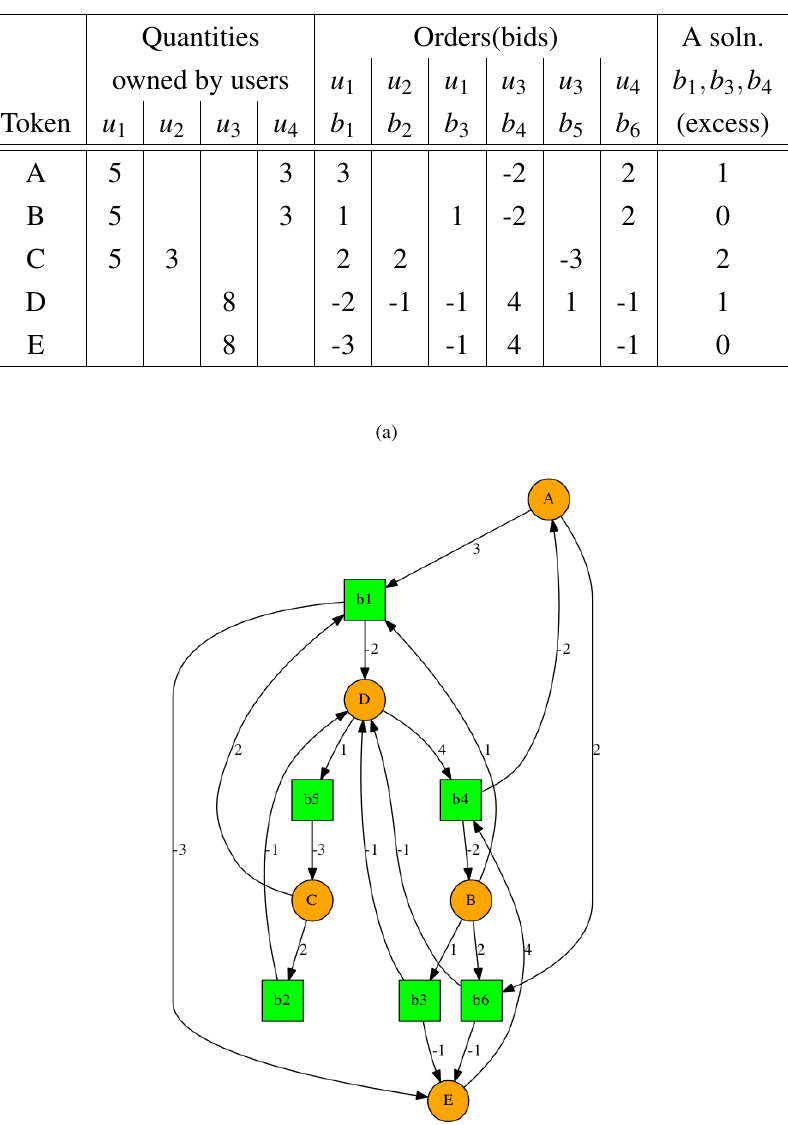
Fig. 2. A token bartering example: tokens, user balances, bids and solution (a) and the corre- sponding bid graph